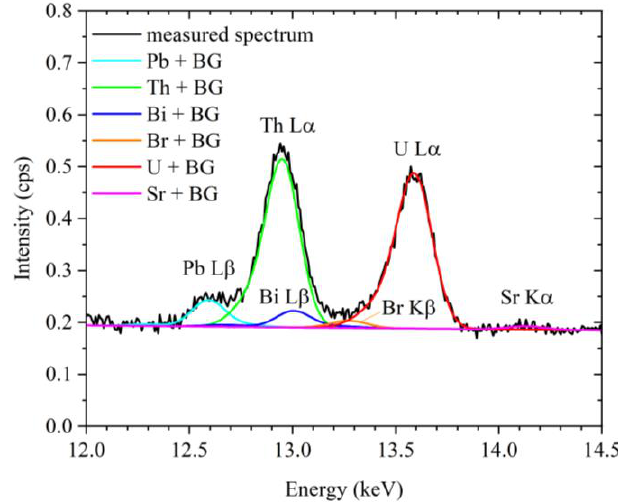
Figure 3. Measured XRF spectrum for one of the standard samples. BG = background intensity.